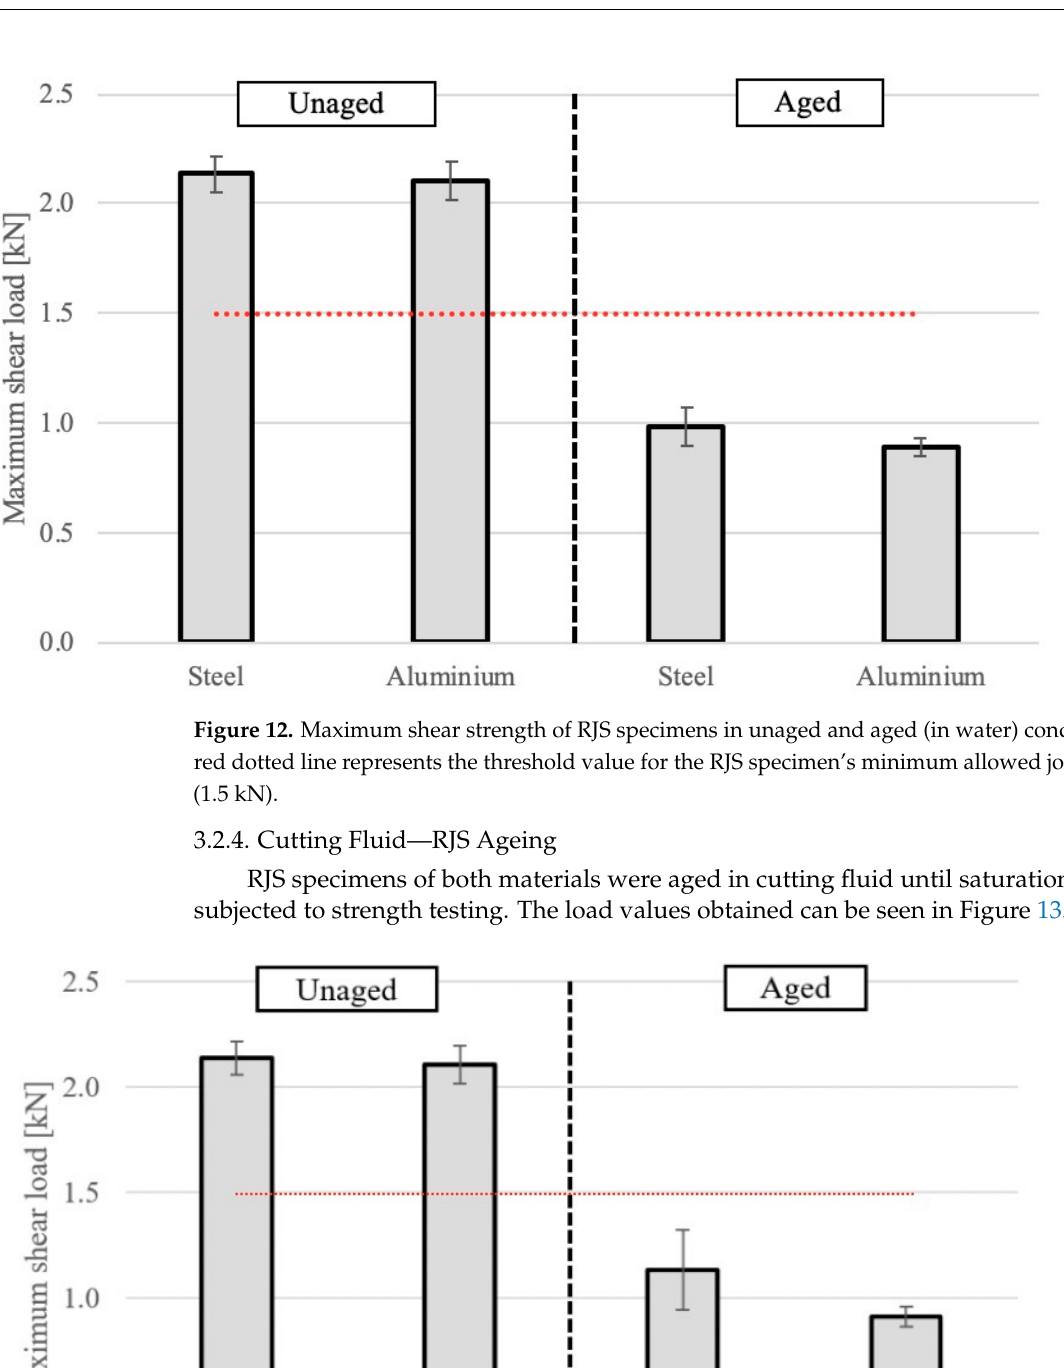
Figure 13. Maximum shear strength of RJS specimens in unaged and aged (in cutting emulsion) conditions. The red do tt ed line represents the threshold value for the RJS specimen’s minimum allowed joint strength (1.5 kN).